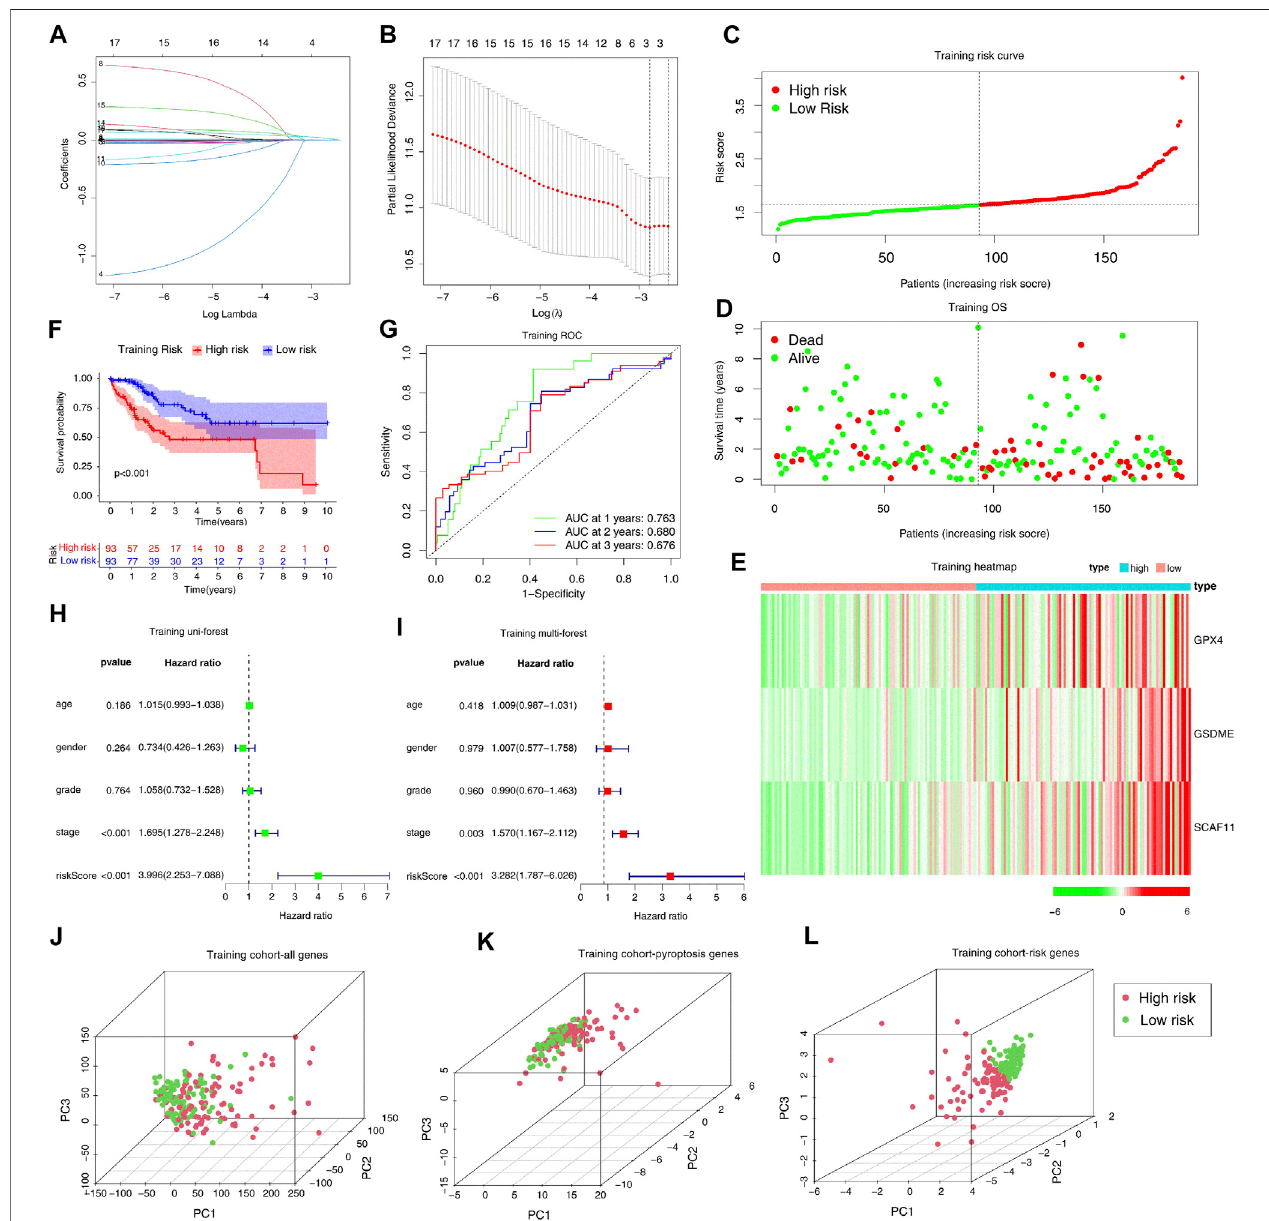
FIGURE3| Construction ofthepyroptosis genes-basedindependentprognostic modelinthe TCGA trainingcohort. (A,B) Construction oftheLASSOregression model basedon the17 predictive genes intheTCGAtraining cohort. (C – E) Distributionofthe riskscores, survivalstatus,and expression ofthethree pyroptosis-related risk genes. (F) The KM analysis of the overall survival in the high-risk and low-risk groups. (G) The ROC analysis to evaluate the predictive ef fi ciency. (H) The univariate Cox analysis to assess the independence of three pyroptosis-related risk genes. (I) Multivariate Cox analysis to assess the independence of three pyroptosis- related risk genes. (J – L) PCA analysis of the high-risk and low-risk groups based on all genes, pyroptosis genes, and three risk genes.